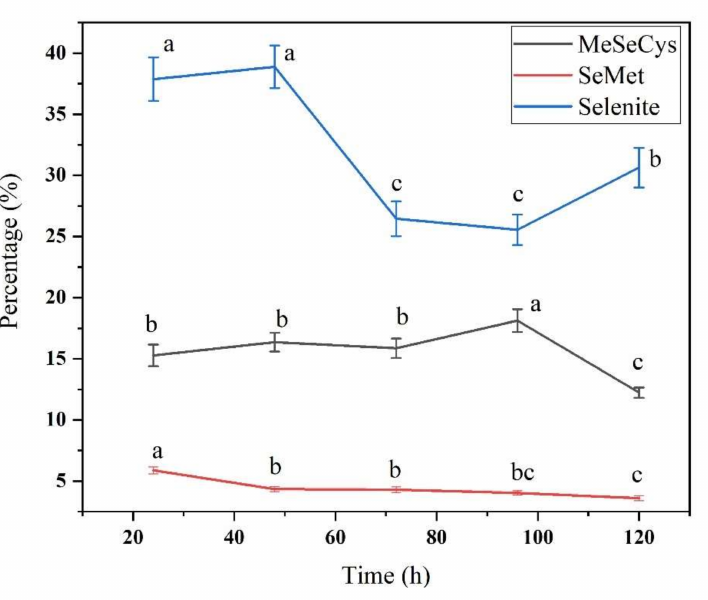
Figure 5. The percentage of three kinds free Se species during soybean germination under 20 mg/L sodium selenite solution. Different letters are used to show significant differences at various treatments ( p < 0.05) in the same Se